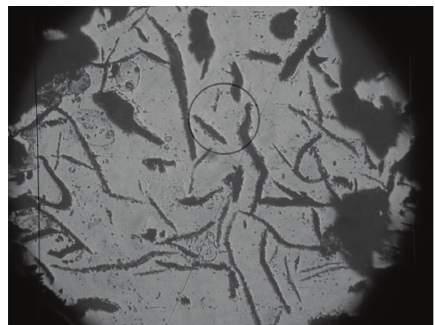
Figure 2: Zone F macroaspect of the sample in the cracked area.